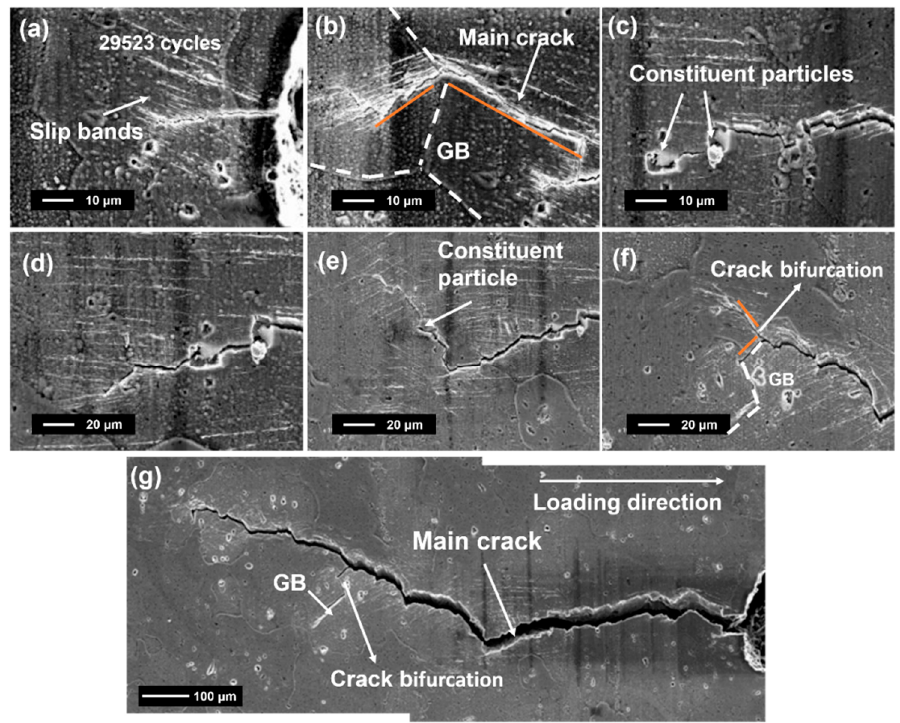
Figure 12. SEM micrographs for the evolution of crack growth of Low Fe alloy ( a ) after 29,523 loading cycles, ( b ) slip bands generated, ( c – e ) the crack propagation behavior when passing through the constituent particles, ( f ) the crack deflection, and ( g ) the overall morphology of crack growth.